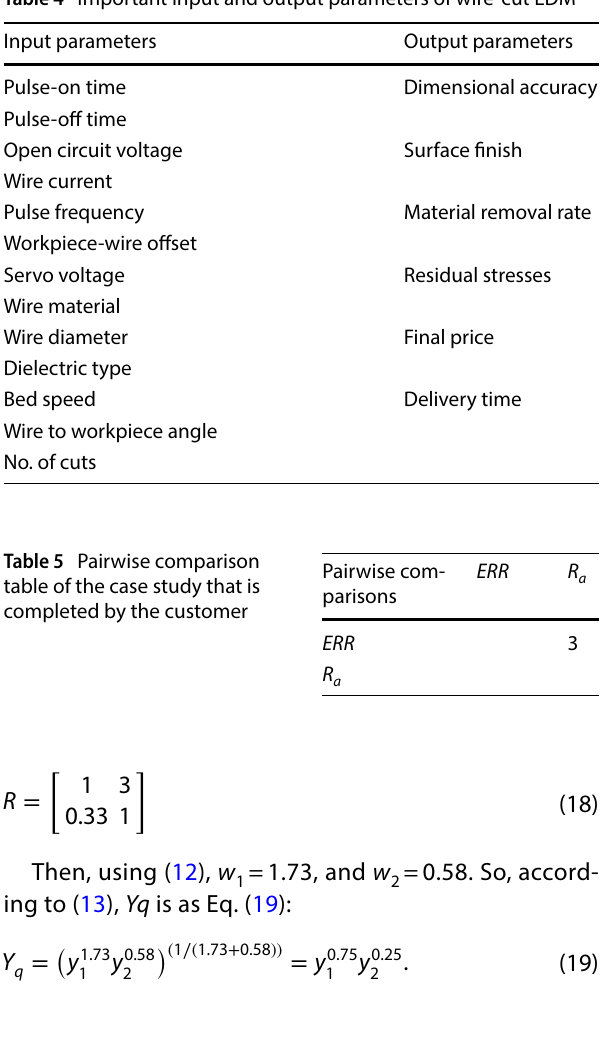
Table 4 Important input and output parameters of wire-cut EDM